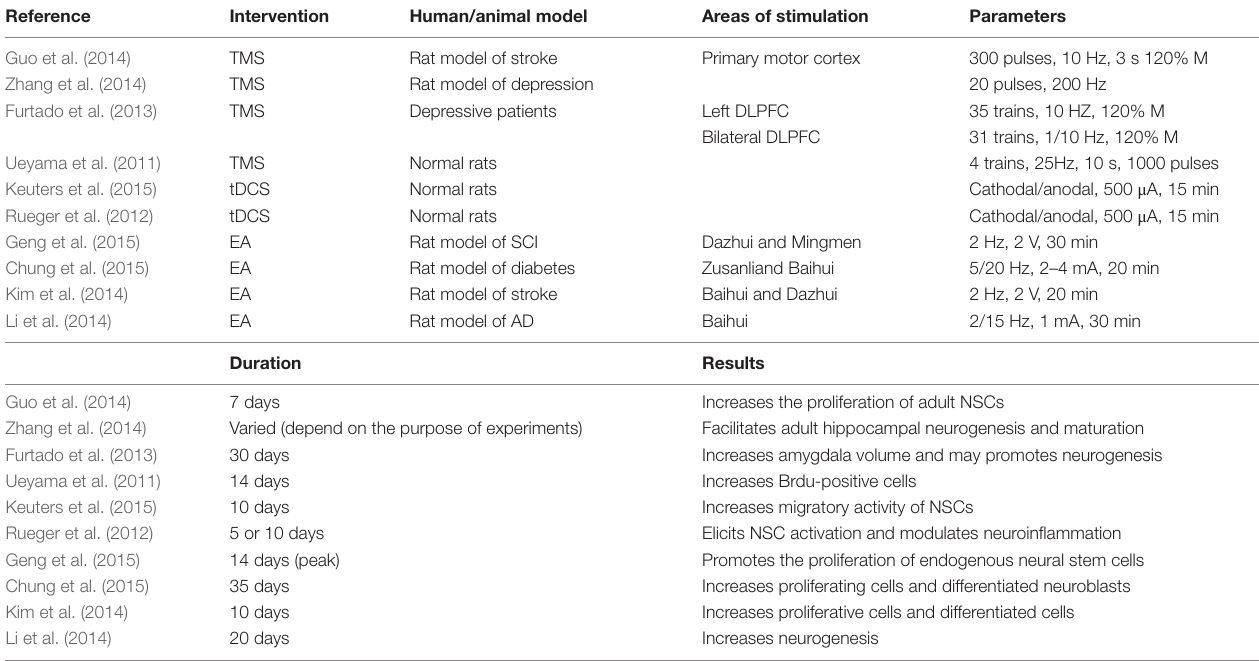
TABLe 2 | Major studies investigating the effects of TMS, tDCS, and eA on NSCs.